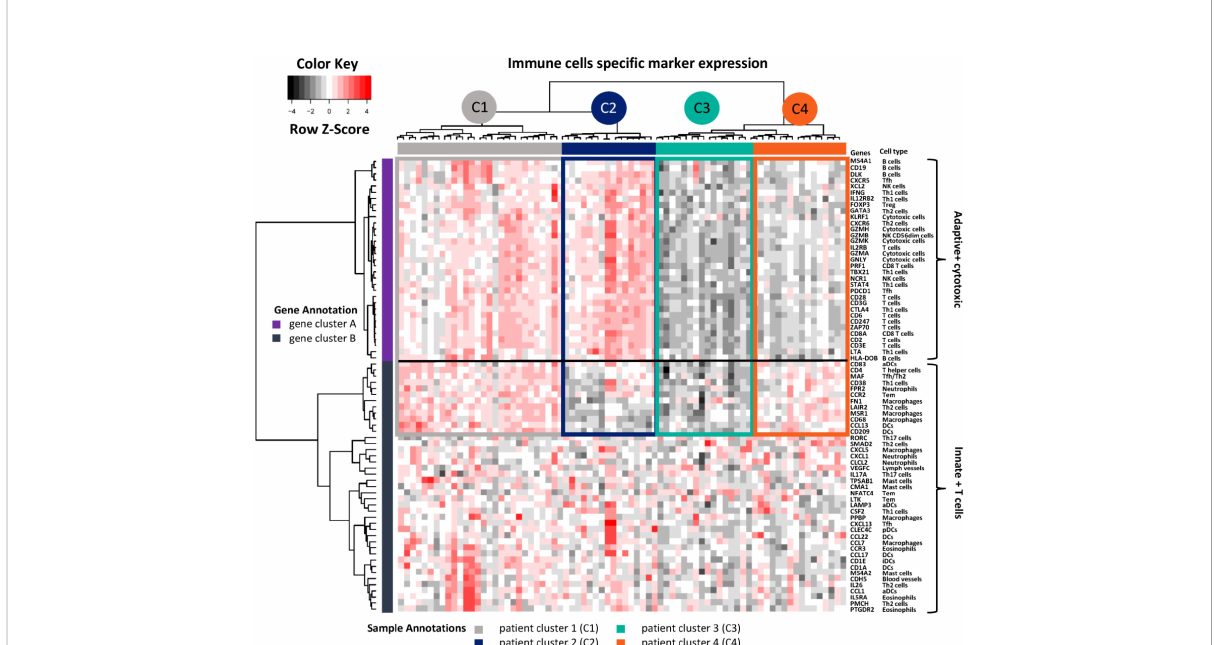
FIGURE 1 Immune cell type-speci fi c gene expression. Unsupervised hierarchical clustering was performed for 74 genes from 75 LADC patient MPE samples. High expressed genes are indicated in red, low ones in black. The corresponding immune cell types are shown on the right side. Genes were further annotated as clusters adaptive + cytotoxic versus innate + T cells. Patients were unsupervised grouped into four clusters (C1 to C4) and annotated with different colours. Th1, T helper cells 1; NK, natural killer cells; Tem, T effector memory; Tfh, T follicular helper cells; T gd , T gamma delta; Treg, regulatory T cells; DCs, dendritic cells; iDCs, immature DCs; aDCs, activated DCs; pDCs, plasmacytoid dendritic